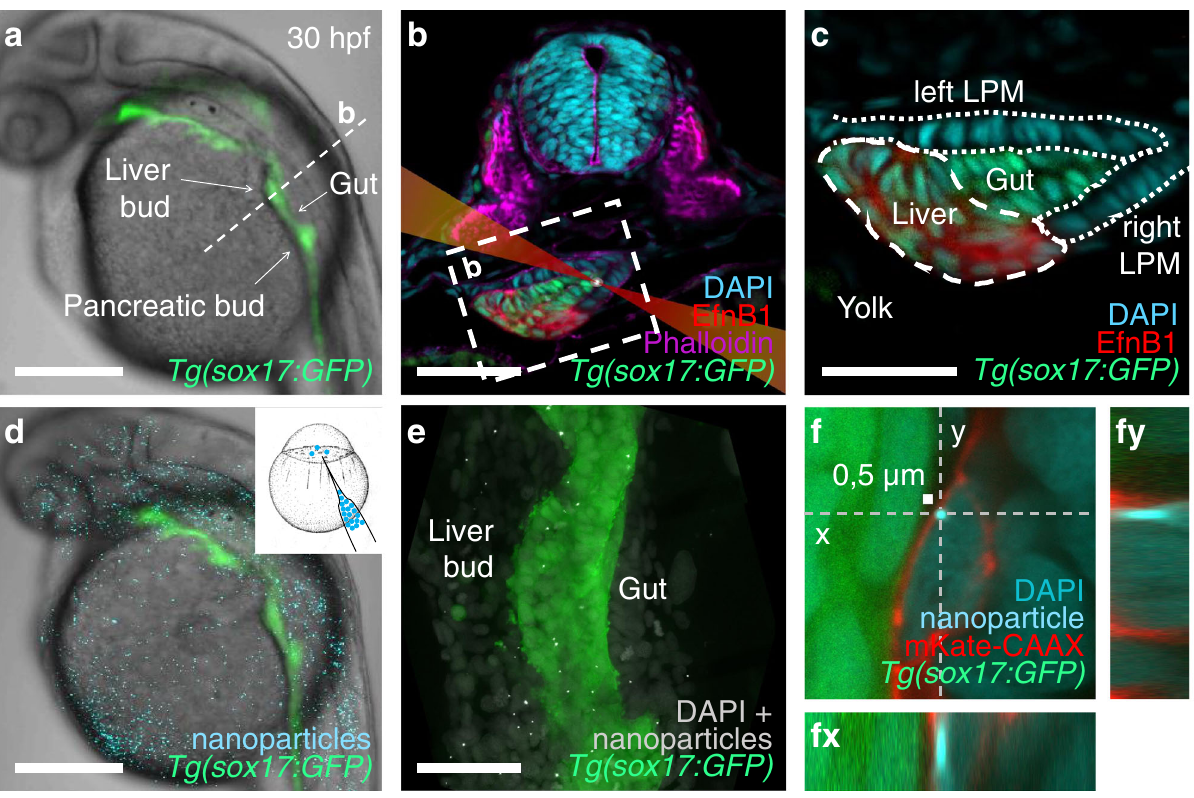
Fig. 1 Injected nanoparticles distribute throughout the embryo, including the foregut region in 28 – 30 hpf zebra fi sh embryos. a Transgenic tg(-0.5 sox17:GFP) zf99 visualizes the endoderm in a living zebra fi sh embryo, including the foregut organ primordia. b Transverse section through the foregut region (dashed line in a) with schematized laser beam path (red) and bead (white). The foregut endoderm expresses transgenic sox17:GFP (green) and liver progenitors EphrinB1 (red); DAPI marks nuclei (cyan); and Phalloidin marks F-actin (magenta). c Magni fi cation of the foregut region shown in ( b ) (white dashed rectangle). d 0.5 µ m polystyrene particles (cyan) microinjected at the one-cell stage distribute throughout the embryo, including the endoderm (green), without causing apparent morphological defects. e Maximum intensity projection of confocal z-stack showing nanoparticle distribution (white) in the foregut region, GFP marks the endoderm. f Confocal image of a representative nanoparticle (light blue) located in the cytoplasm between the nucleus (darker blue) and plasma membrane (red) in a fi xed embryo. (fy) and (fx) show orthogonal views in the “ yz ” plane (dashed line “ y ” in ( f )) and “ xz ” plane (dashed line “ x ” in ( f )), respectively. Scale bars a , d : 250 µ m; b , e : 50 µ m; c : 30 µ m; f : 0,5 µ m (scale bar next to